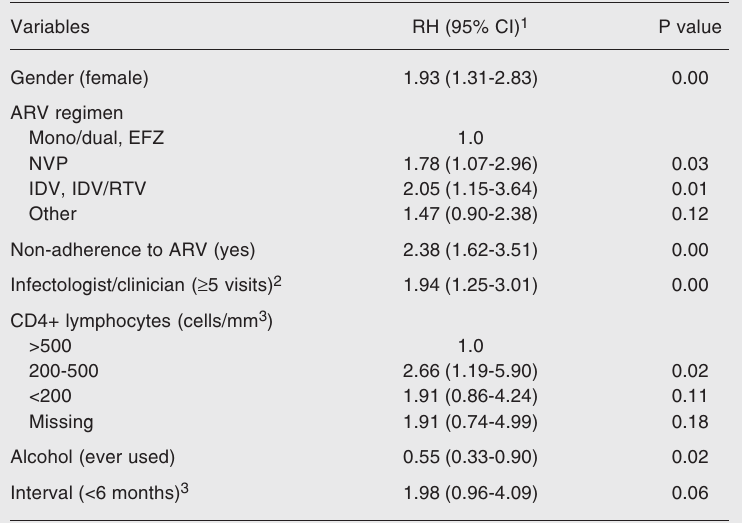
Table 4. Adjusted relative hazards with a 95% confidence interval (95% CI) obtained from the final model multivariate analysis of adverse reactions among patients admit- ted to two AIDS/HIV public referral